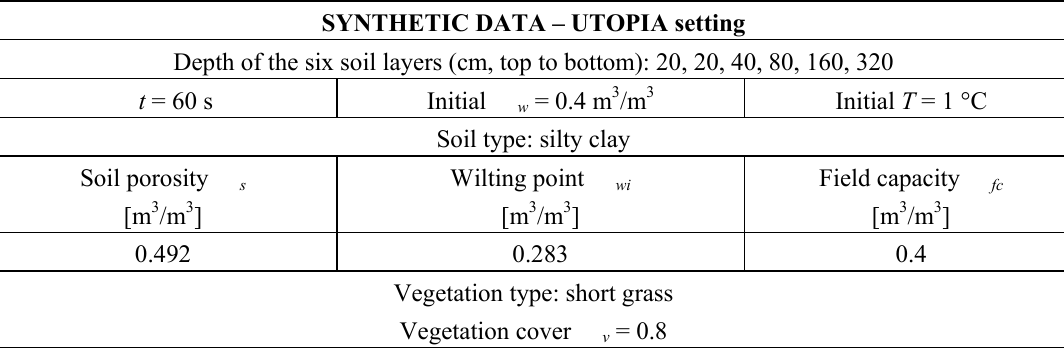
Table 1. Model setting for the simulation with the synthetic